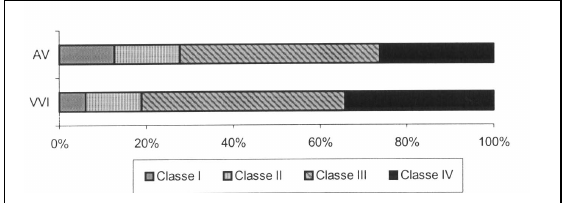
Fig. 8b - Modos de estimulação utilizados nos implantes iniciais, agrupados segundo a classificação funcional dos pacientes para insuficiência cardíaca congestiva.